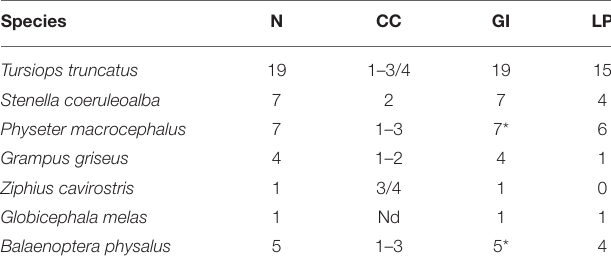
TABLE 1 | Sampled animals listed by species, conservation condition of the carcasses, and number of sampled organs.